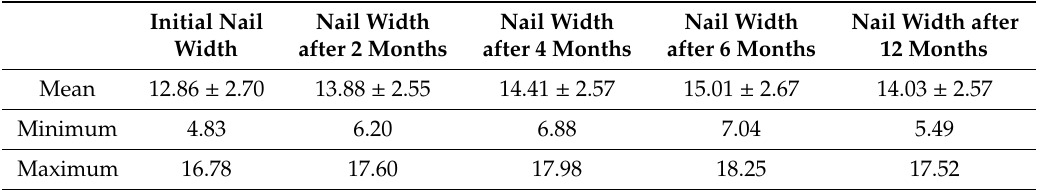
Table 2. Descriptive parameters of the nail width measurements in the experimental group. Initial Nail Nail Width